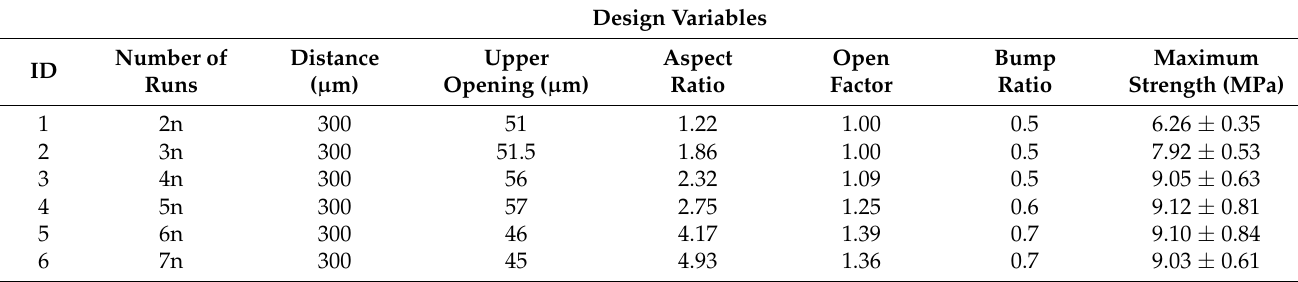
Table 3. Parameterization of experiments with single lap joint and experimental